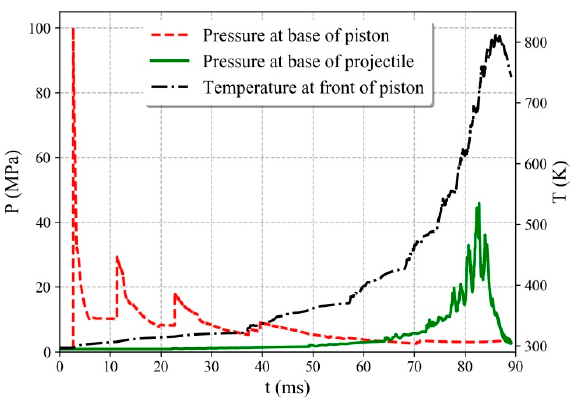
Figure 7. Piston speed versus piston travel distance. Figure 8. Simulated pressure and temperature at the base and front of the projectile or piston for Case 1.